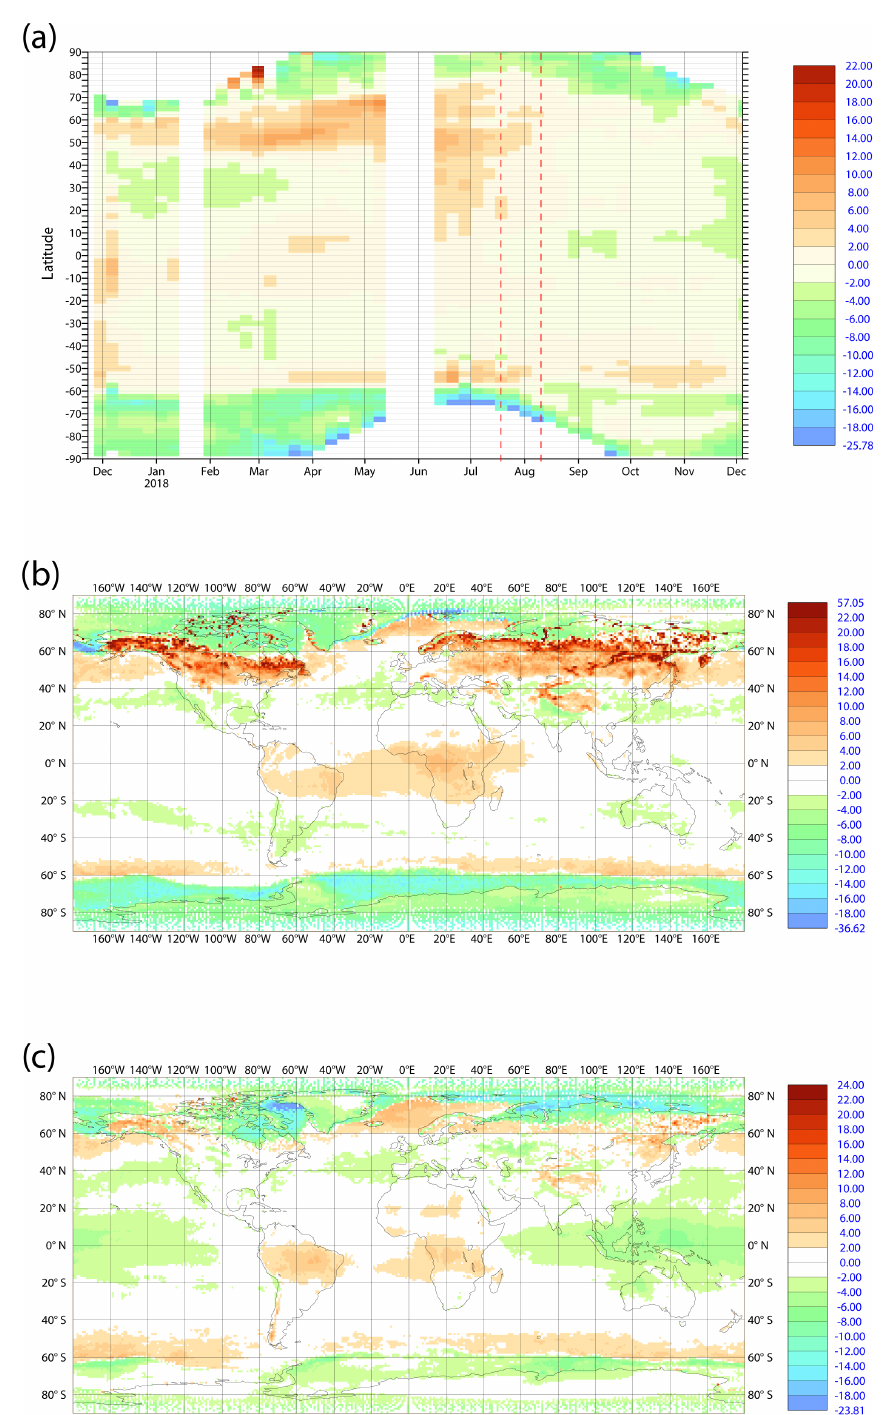
Figure 5. (a) Time series of zonal mean weekly averaged TROPOMI TCO3 analysis departures (observations minus analysis) for the period 26 November 2017 to 30 November 2018. The red dashed lines mark changes in the retrieval versions (see Table 2). (b) Mean TROPOMI TCO3 analysis departures averaged over FMA 2018 and (c) mean analysis departures averaged over SON 2018. Only good data are shown. All values are in DU. Values smaller than 2DU are